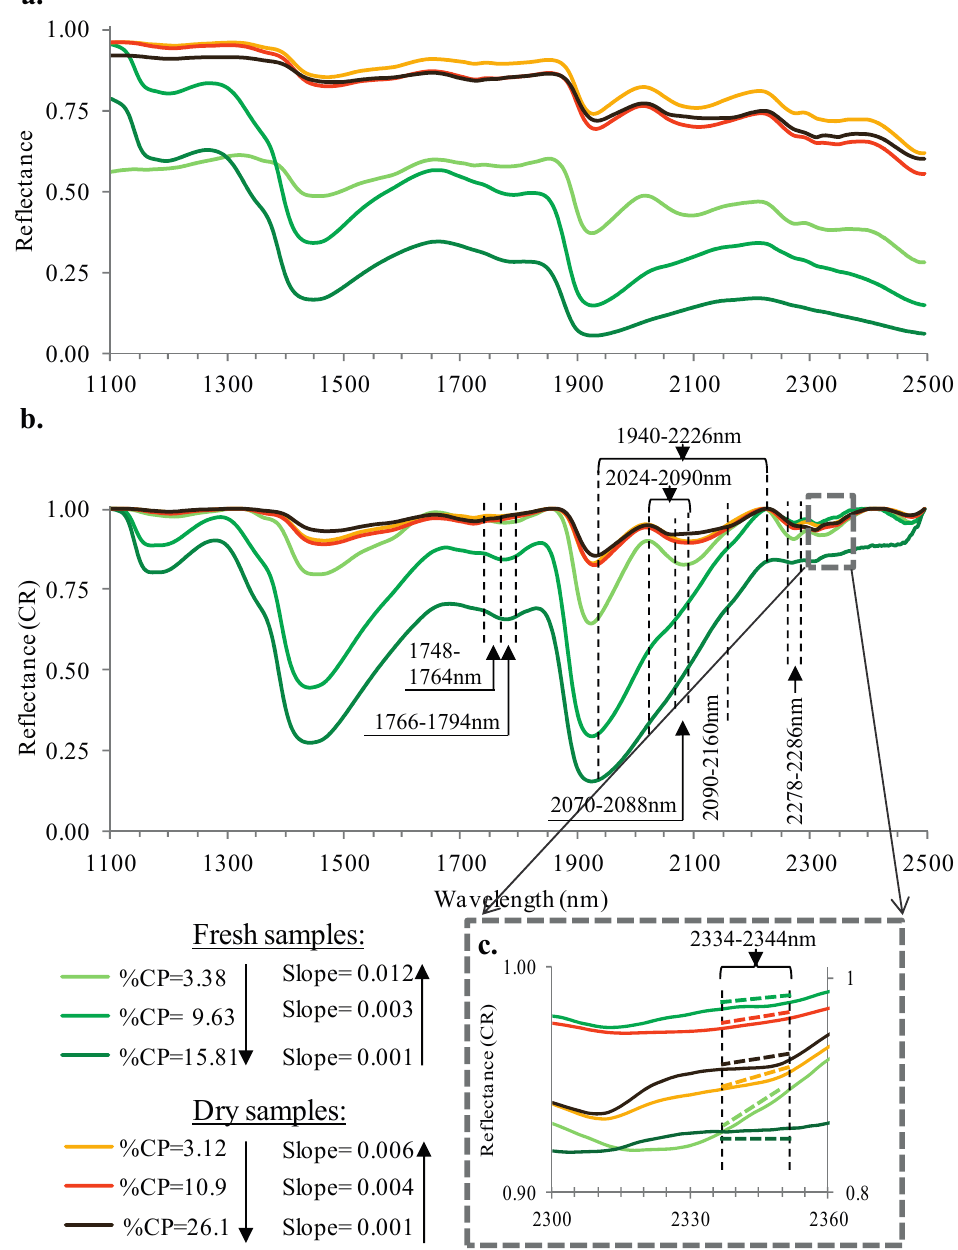
Figure 3. ( a ) Reflectance and ( b ) continuum removal (CR) spectra of fresh and dry vegetation samples with different percentages of crude protein (CP). ( c ) Zooming in on the 2334–2344 nm spectral range to demonstrate the changes in slope with changes in CP concentration. Note the variability in the slopes across the different percentages of CP in the dry and fresh samples. Specifically, as the slope decreases, the CP value